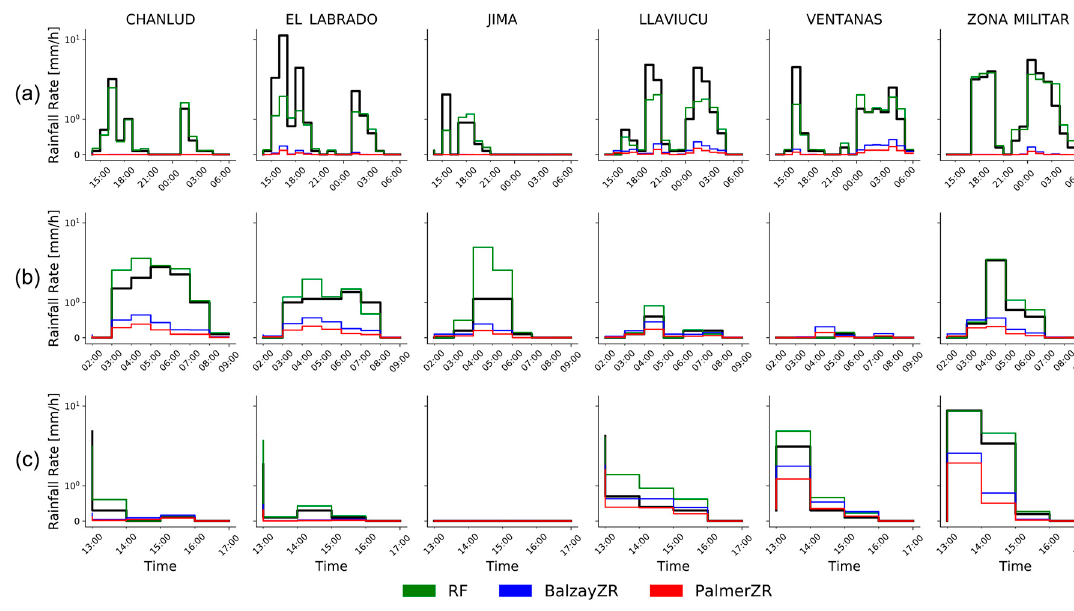
Figure 9. Hyetograms of the three representative rainfall events from the independent test set: ( a ) 09 March 2016 14:00–10 March 2016 07:30, ( b ) 10 June 2016 02:00– 10 June 2016 09:00 and ( c ) 19 March 2017 13:00–19 March 2017 17:00 as seen by the testing stations. Observations are illustrated in black and the three QPE models: random forest (green), step-wise Z–R site specific (blue) and step-wise Z–R Marshall-Palmer (red) at an hourly frequency.